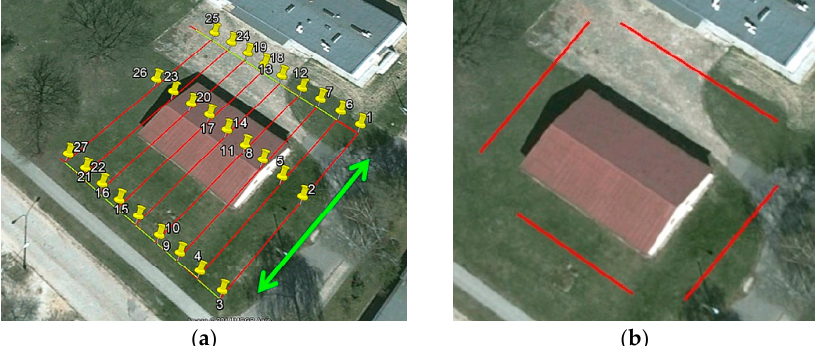
Figure 7. Flight plan for the aerial orientation ( a ) and terrestrial orientation ( b ). The numbers 1–27 represent the POIs. The red lines represent the UAV flight path, with the green line showing the direction of flight of the UAV.